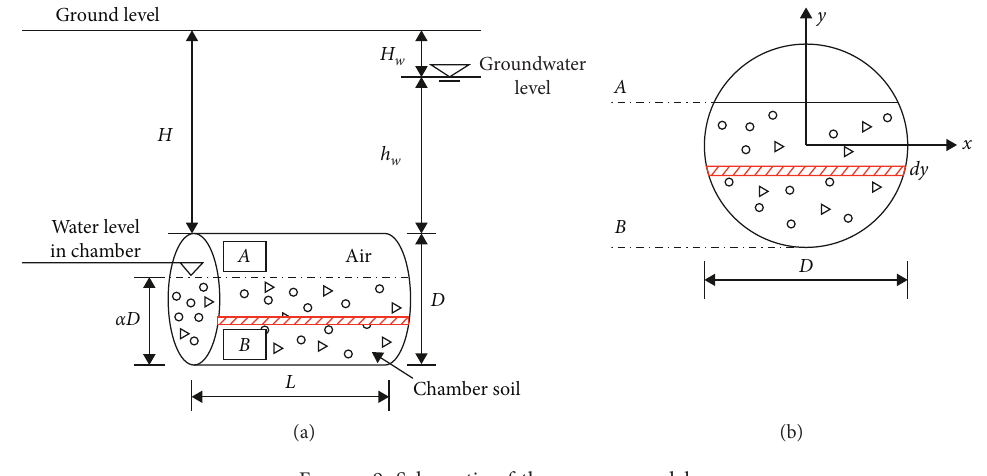
Figure 9: Schematic of the seepage